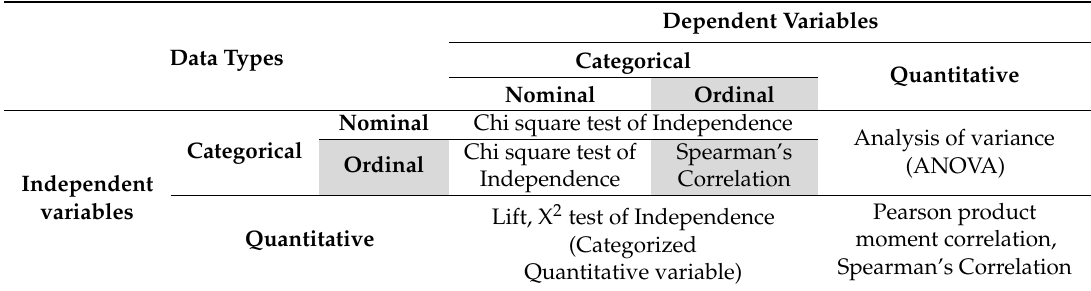
Table 1. Correlation techniques based on data types. The highlighted Spearman’s correlation shows that it considers only ordinal data in the categorical dataset